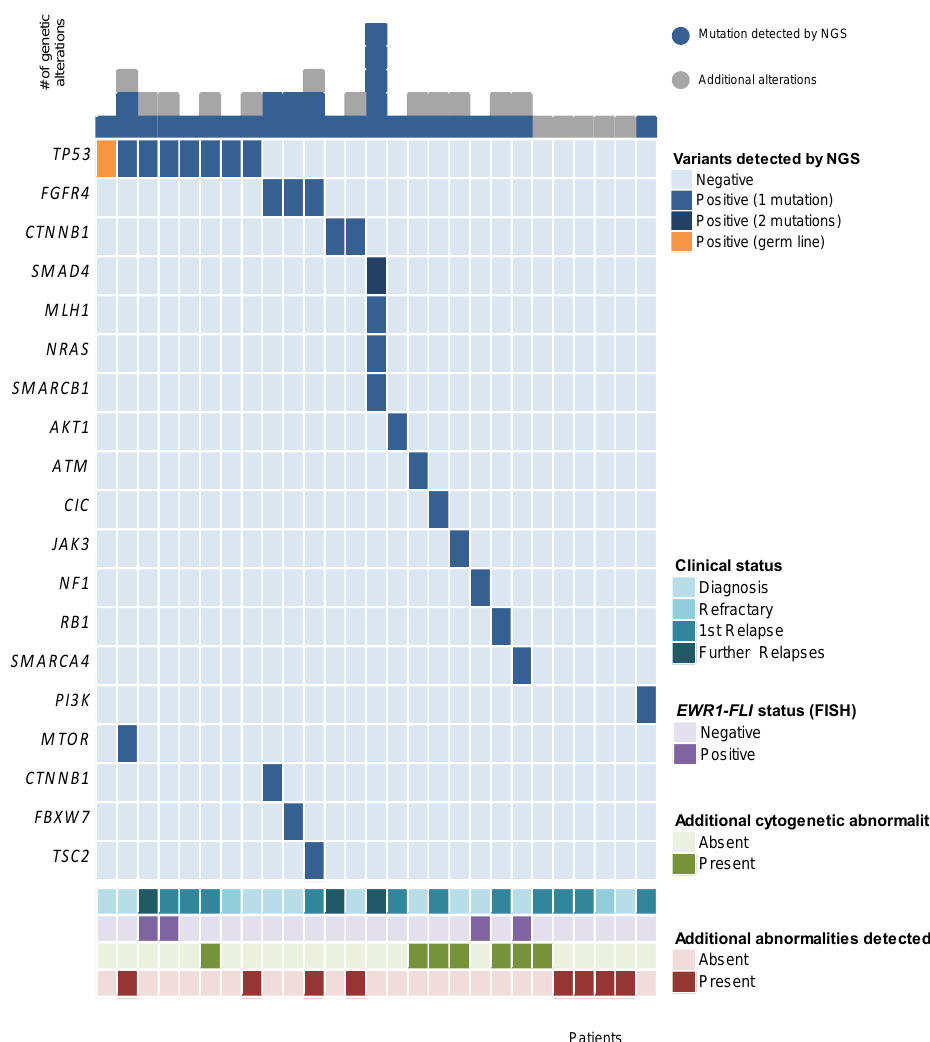
Figure 2. Molecular alterations observed in the 27 patients (each column represents one patient). IHC: immunochemistry.